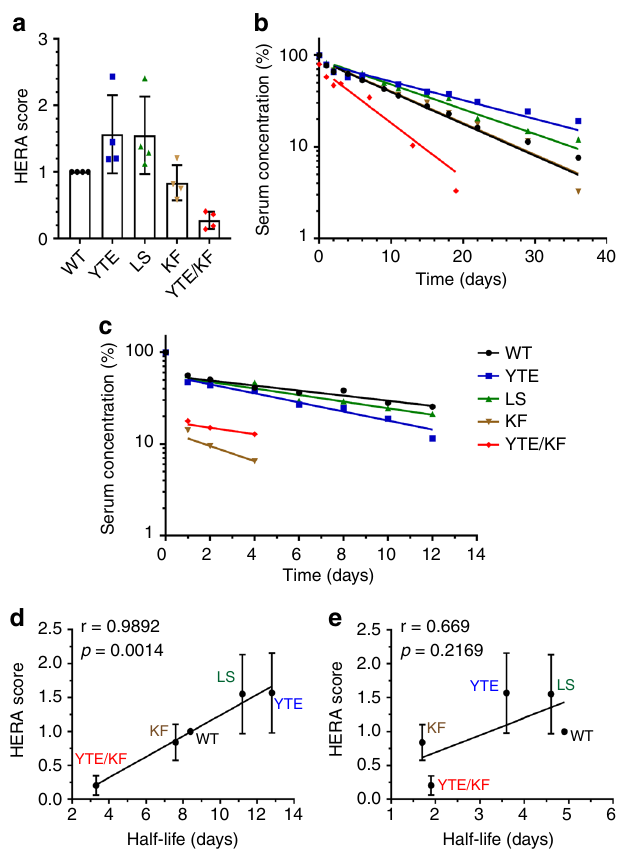
Fig. 6 HERA score correlates with in vivo serum half-life in hFcRn transgenic mice. a HERA score for the WT and the Fc-engineered hIgG1 variants were calculated from the data shown in Fig. 5e, f. b , c Log-linear changes in the serum concentration of hIgG1 WT (black), YTE (blue), LS (green), KF (brown) and YTE/KF (red) in hFcRn transgenic mice and WT mice, respectively. The antibodies were administrated as a single i.v. injection to 5 mice per group. Correlations of the derived HERA scores with serum half-life values of hIgG1 variants obtained from d hFcRn transgenic ( r = 0.9892, p < 0.0014) and e WT mice ( r = 0.669, p < 0.2169). The data are represented as mean ±